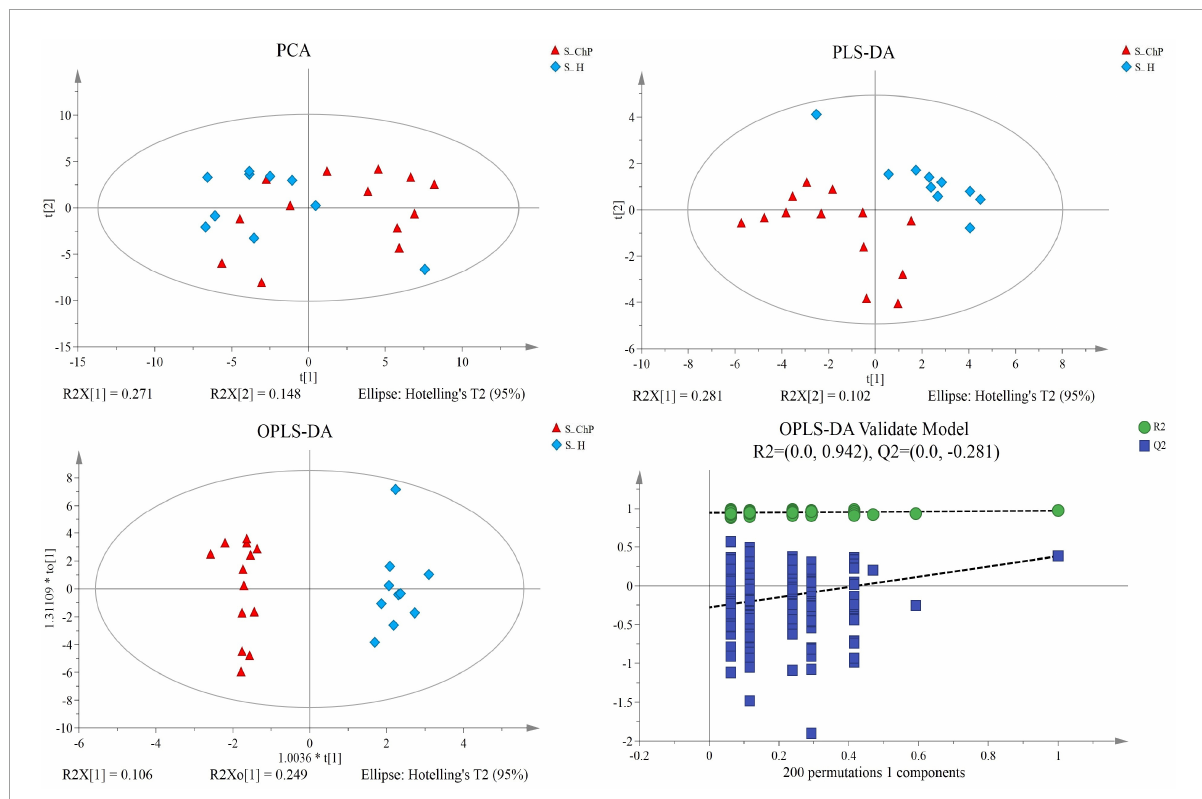
FIGURE5 Dissimilarity of salivary metabolic signatures between ChP and PH. PCA analysis (A) , PLS-DA analysis (B) , OPLS-DA analysis (C) , and response permutation testing of OPLS-DA (D) .